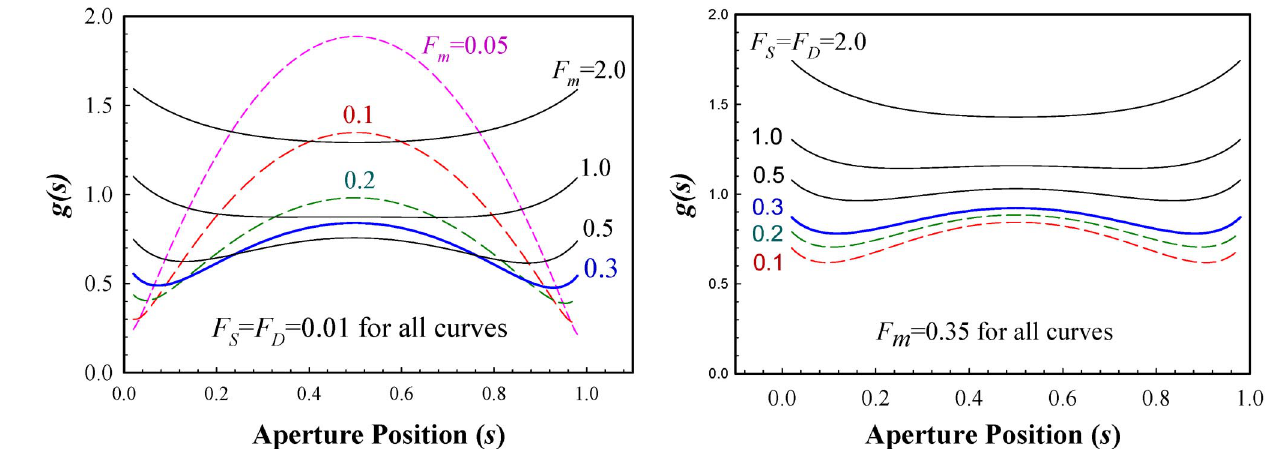
(cid:3) F (cid:3) 0 : 01 , left graph). Function g (cid:6) s (cid:7) for S D